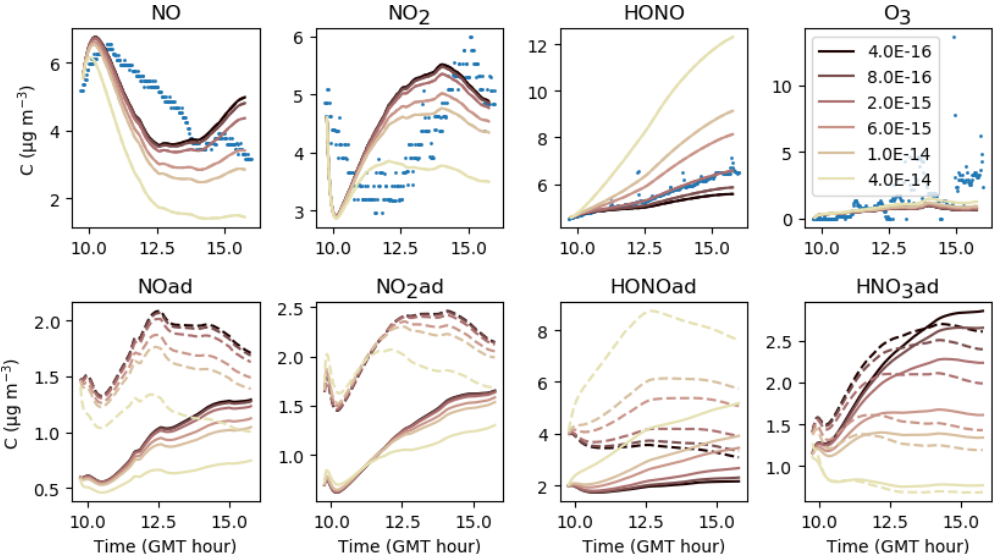
Figure 16. Gas-phase and adsorbed inorganic compounds simulated for different k S4 . The blue dots denote the experimental measurements (Experiment 2). The solid lines represent the concentrations in the sunlit box and the dashed lines the concentrations in the shaded